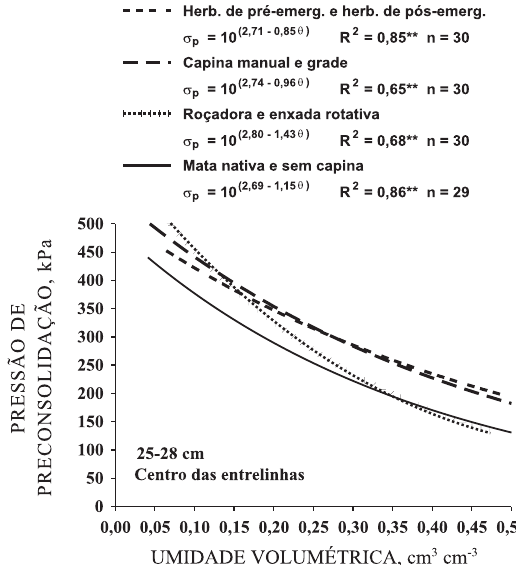
Figura 6. Modelos de capacidade de suporte de carga para um Latossolo Vermelho distroférrico sob mata nativa cultivado com cafeeiros e submetido a diferentes sistemas de manejo de plantas invasoras na posição de amostragem centro das entrelinhas dos cafeeiros, na profundidade de 25–28